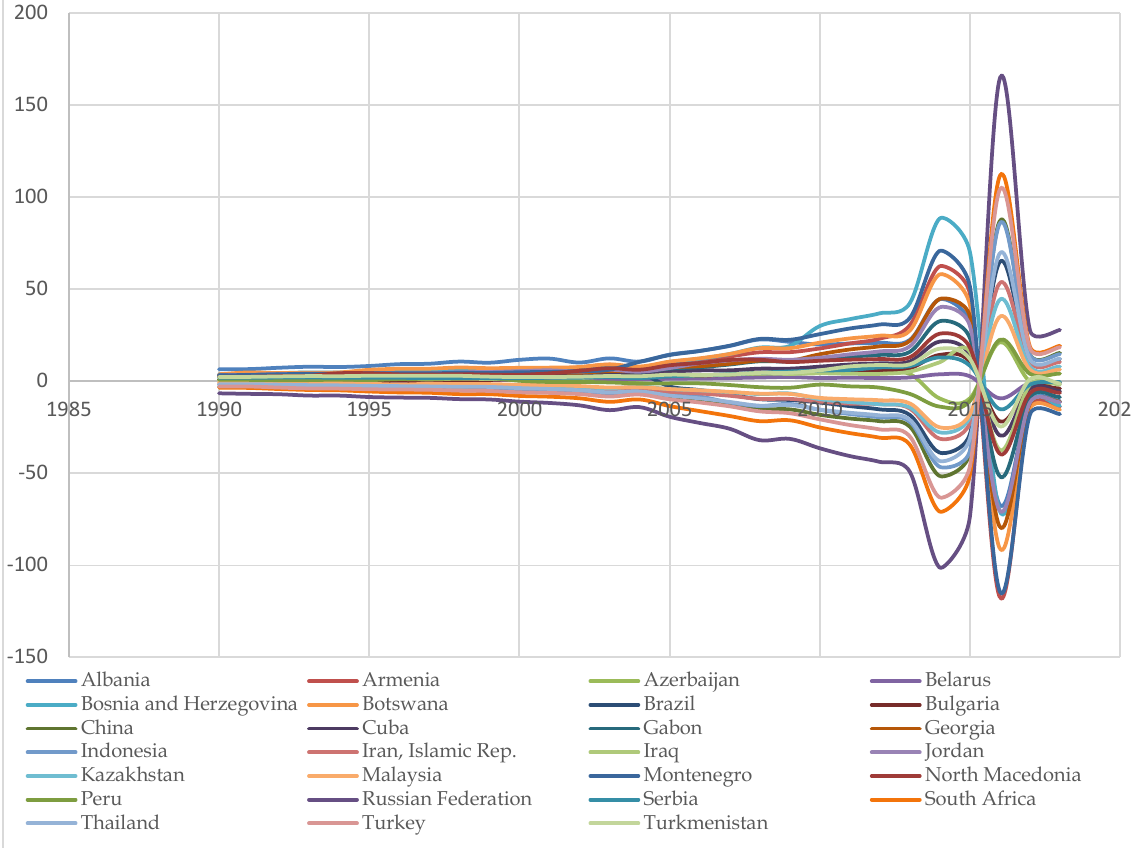
Figure 4. Transportation panel transition paths for Upper-middle-income countries (UMIC)